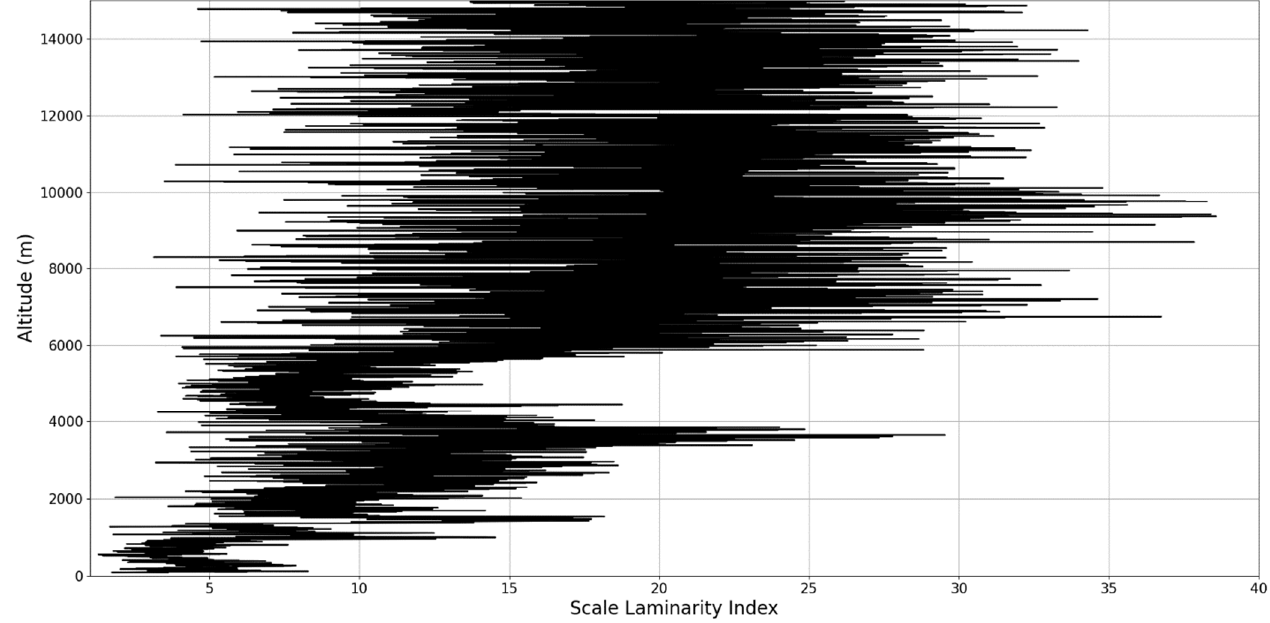
Figure 31. Scale laminarity index profile plot corresponding to point B in the vicinity of the PBLH.